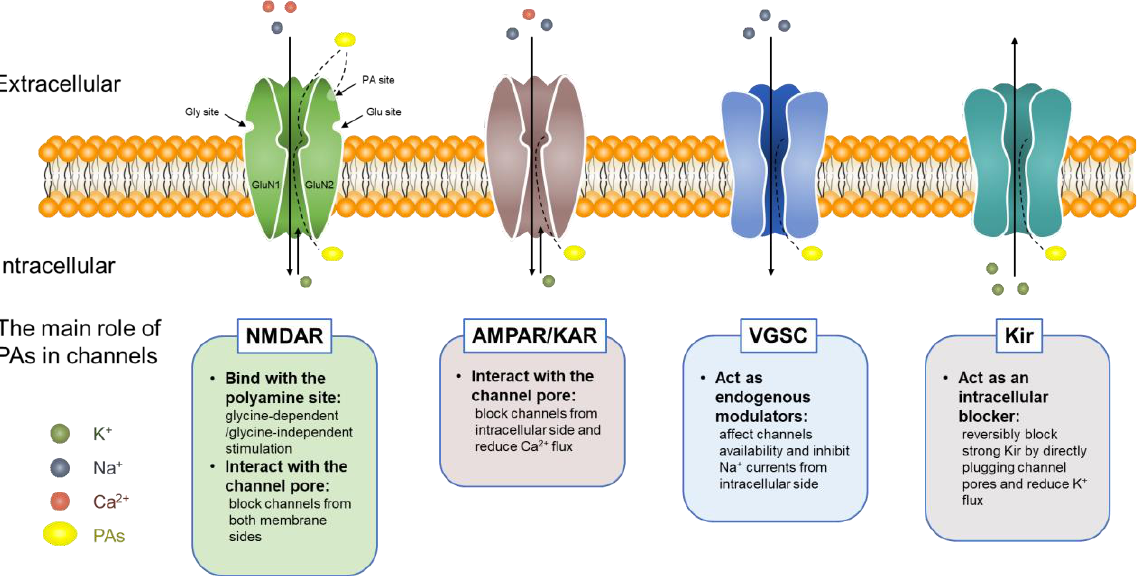
Figure 4. The main role of polyamines in different ion channels and receptors. Intracellular spermine suppressed inward Na + currents and shifted the voltage de- pendence of voltage-gated Na + channel (VGSC) gating [102]. Fleidervish and colleagues